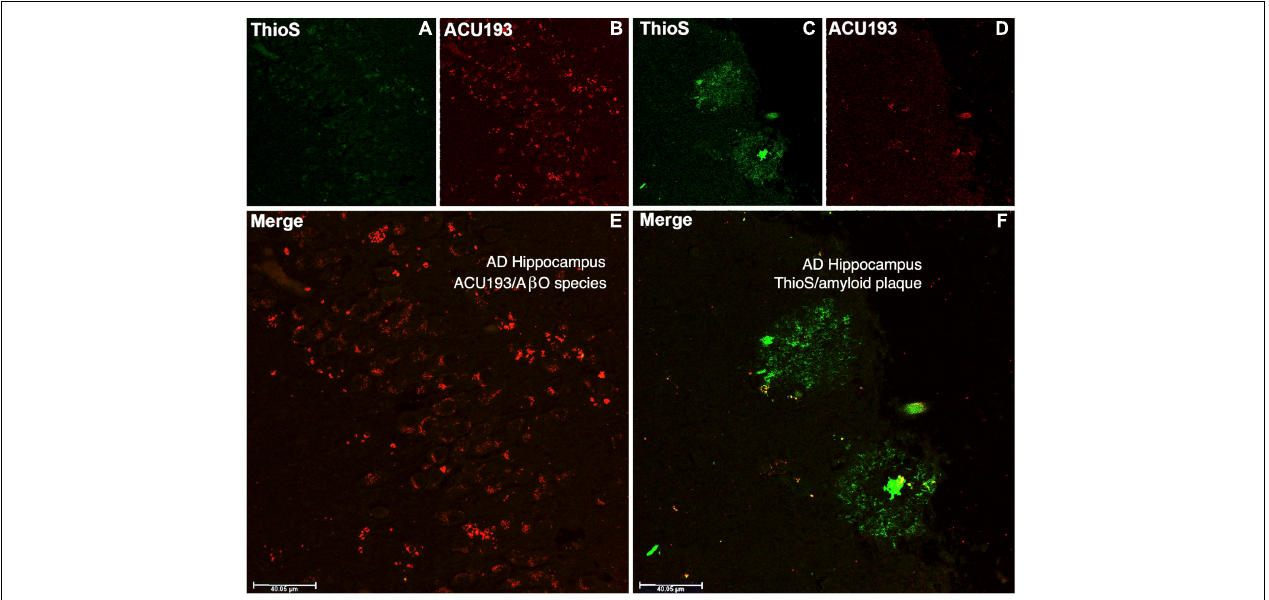
FIGURE 4 | The upper left portion of the immunohistochemistry figure shows that in areas of advanced AD hippocampal tissue with no amyloid plaque binding (no green fluorescent ThioS staining, (A) there is substantial ACU193 binding (red fluorescent staining, (B) not related to amyloid plaque. The merge of these panel (E) shows ACU193 binding with no amyloid plaque present. On the upper right portion of the figure, the area that is positive for amyloid plaque (green fluorescent staining, (C) shows minimal ACU193 binding (red fluorescent staining, (D) . The merge of these panel (F) shows the minimal binding of ACU193 (red fluorescent staining) at the periphery of the amyloid plaque (green fluorescent staining), most likely related to A β Os binding at or associating with the periphery of the amyloid plaque.